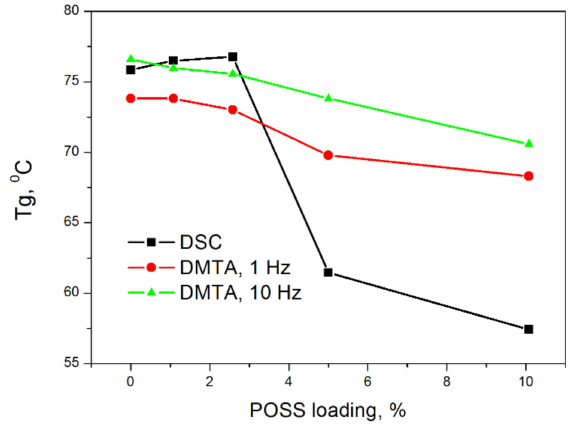
Figure 3. The changes in Tg of PVC nanocomposites as a function of MeOctPOSS concentration measured by DSC and DMA at various frequencies